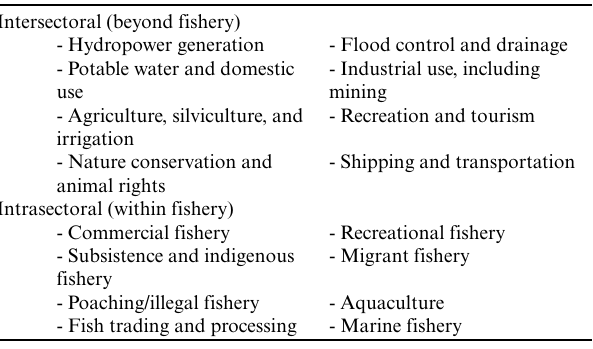
Table 2. List of external sectors that interact with inland fisheries and also internal groups that could be featured in an inland fishery (note: these are representative labels, thus not necessarily mutually exclusive, e.g., water quality overlaps with the concerns of